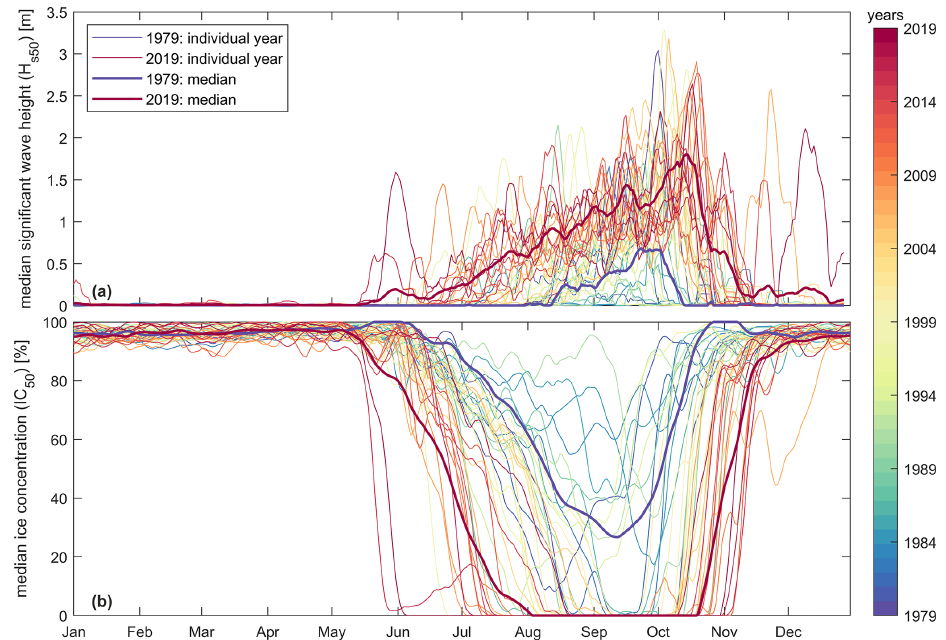
Figure 12. Time series of the daily median significant wave height ( H s50 ) for 41 years of wave data across Foggy Island Bay as simulated by the intermediate SWAN domain (a) and daily median ice concentration (b) . Time series are smoothed by applying a moving weekly filter. The median estimate for 1979 and 2019 is based on a linear fit per day of the individual years.